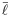
Notch is required for the characteristic straight shape of the DV boundary and for the local increase in cell bond tension.(A,B) Wing discs from control and Nts mutant larvae reared for 48 h at 29°C and expressing GFP (red) in the dorsal compartment (apGal4, UAS-GFP) were stained for E-cadherin (green) to visualize adherens junctions. Scale bars: 10 μm. (C,D) Segmentation of the images shown in (A) and (B). The red line marks the DV boundary. (E) Roughness w of the DV boundary for the segment lengths L for the genotypes indicated in (A,B). Segment length and roughness values are normalized by the average cell bond length in the tissue l¯ = 1.7 μm. Mean and s.e.m. are shown (control, n = 7 wing discs; mutant, n = 7 wing discs). P <0.01–0.05 for L = 1–2. (F,G) Change in distance d between the vertices of cell bonds located within the compartments (comp.) or at the DV boundary after ablation (normalized to l¯) as a function of time for wing discs of control and Nts mutant larvae reared for 48 h at 29°C. Mean and s.e.m. are shown (control, n = 14 comp., n = 11 DV; mutant, n = 9 comp., n = 10 DV cuts). (H,I) Initial velocity of vertex displacement after ablation of the indicated types of cell bonds for control (H) and Nts mutant (I) larvae reared for 48 h at 29°C. Mean and s.e.m. are shown (n as in F,G). *** P<0.001; n.s. not significant.